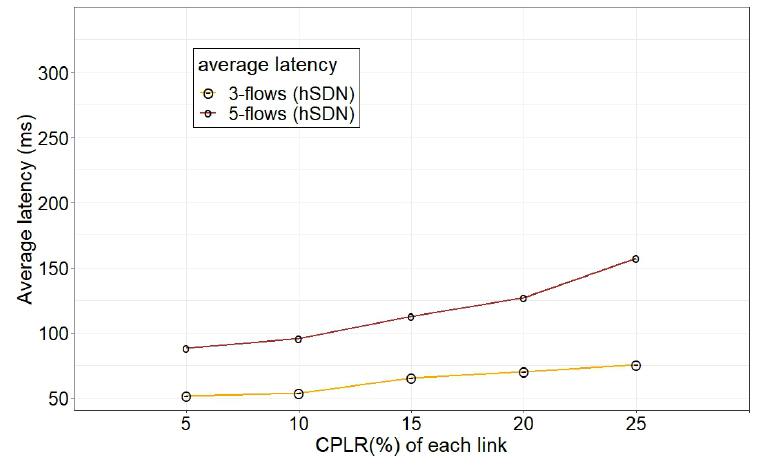
Figure 17. Data plane performance (average latency) of hSDN during data plane link failures for various times under unreliable control plane conditions in a 9-node grid network.